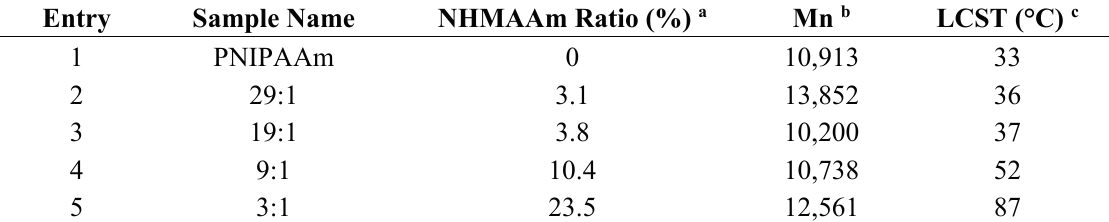
Table 2. Information of